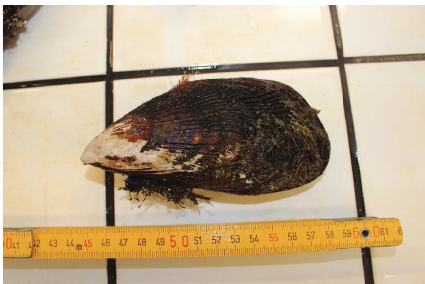
Figure 1: Aulacomya ater . A specimen of A. ater collected in the deep subtidal water at Port-aux-Franc¸ais, in the Kerguelen